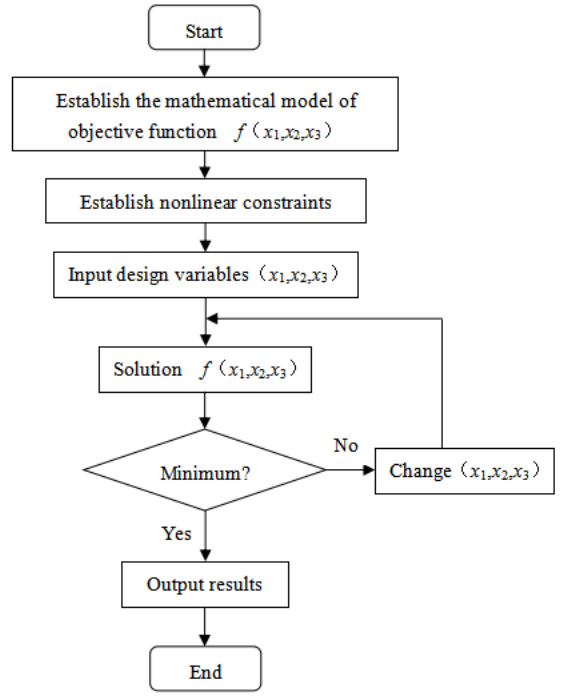
Figure 6. Calculation flowchart for MATLAB.